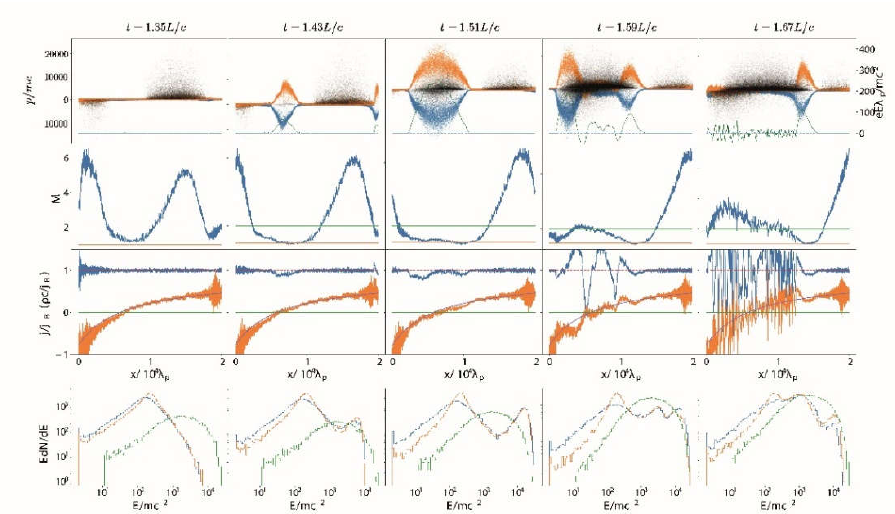
Figure 6. Time evolution of the gap. From left to right are snapshots at labeled times, where L is the size of the box. The panels from top to bottom are: (1) phase space plots for electrons (blue), positrons (orange), and photons (black). The green line is electric field and its scale is on the right. (2) Pair multiplicity M . Orange and green lines mark M = 1 and 2, respectively. (3) Current j (blue) and charge density (orange) and their background values. (4) Spectrum of electrons (blue), positrons (orange), and photons (green). Adapted with permission from [83].